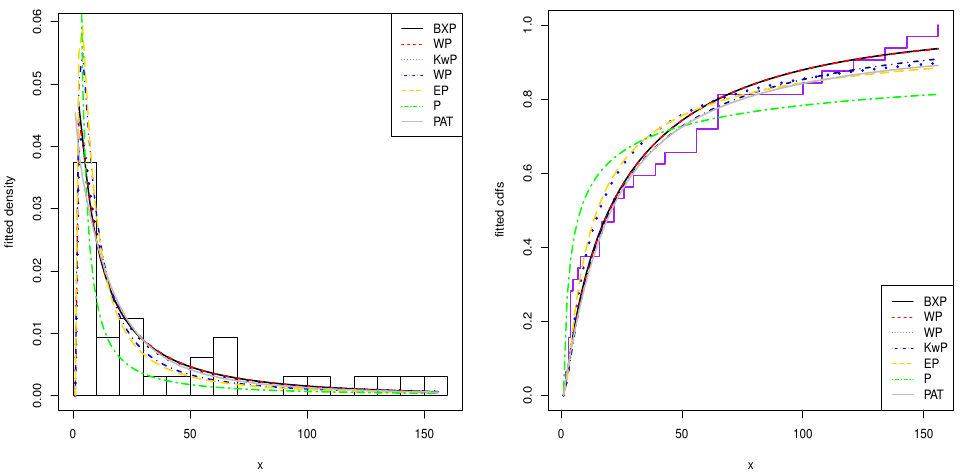
Figure 2. Fitted pdfs ( left panel ) and cdfs ( right panel ) of leukaemia data.